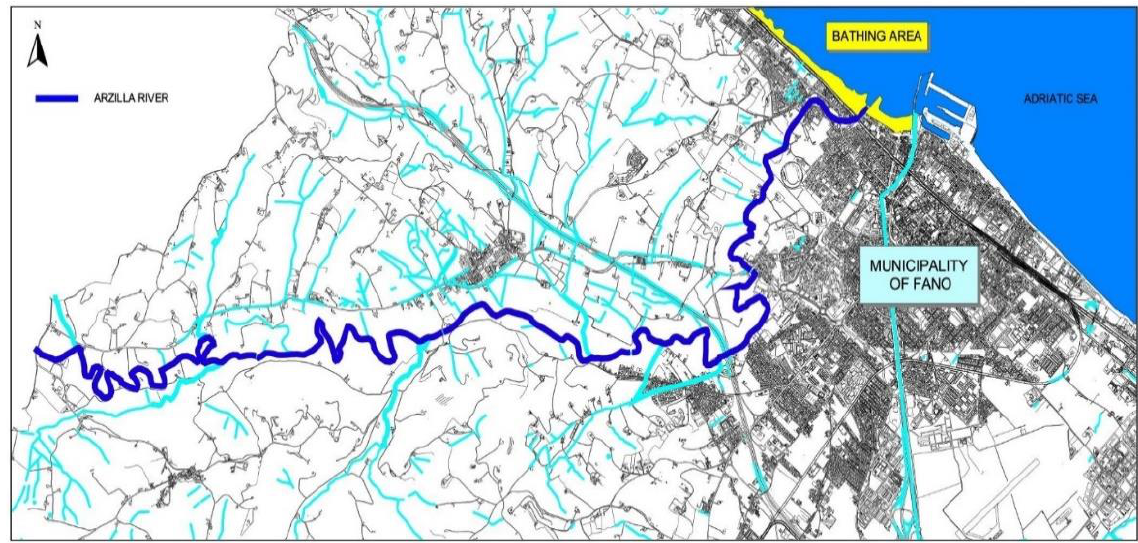
Figure 1. Study area with the course of the Arzilla River (blue) and the recreational beach (yellow). As shown in Figure 2, there are two sewer catchments, one in via del Moletto (basin A; 3.40 hectares) and the other in via 1 ◦ Maggio (basin B; 3.80 hectares), whose drainage